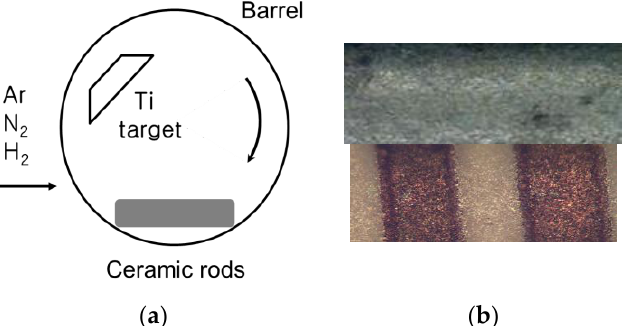
Figure 1. ( a ) Schematic diagram of the direct current (DC) sputtering system utilized for TiN deposition on ceramic rods. ( b ) TiN films grown on ceramic rods. The upper one was grown with N 2 only. The lower one was grown with N 2 + H 2 , etched for characterization.